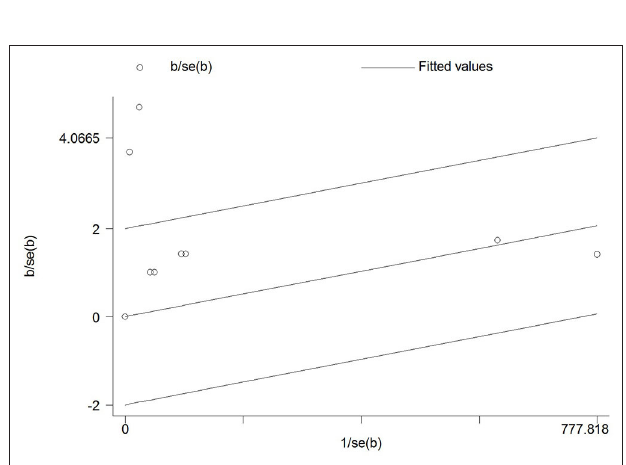
FIGURE 4 | Galbraith of the meta-analysis on the prevalence of skin manifestations among patients with